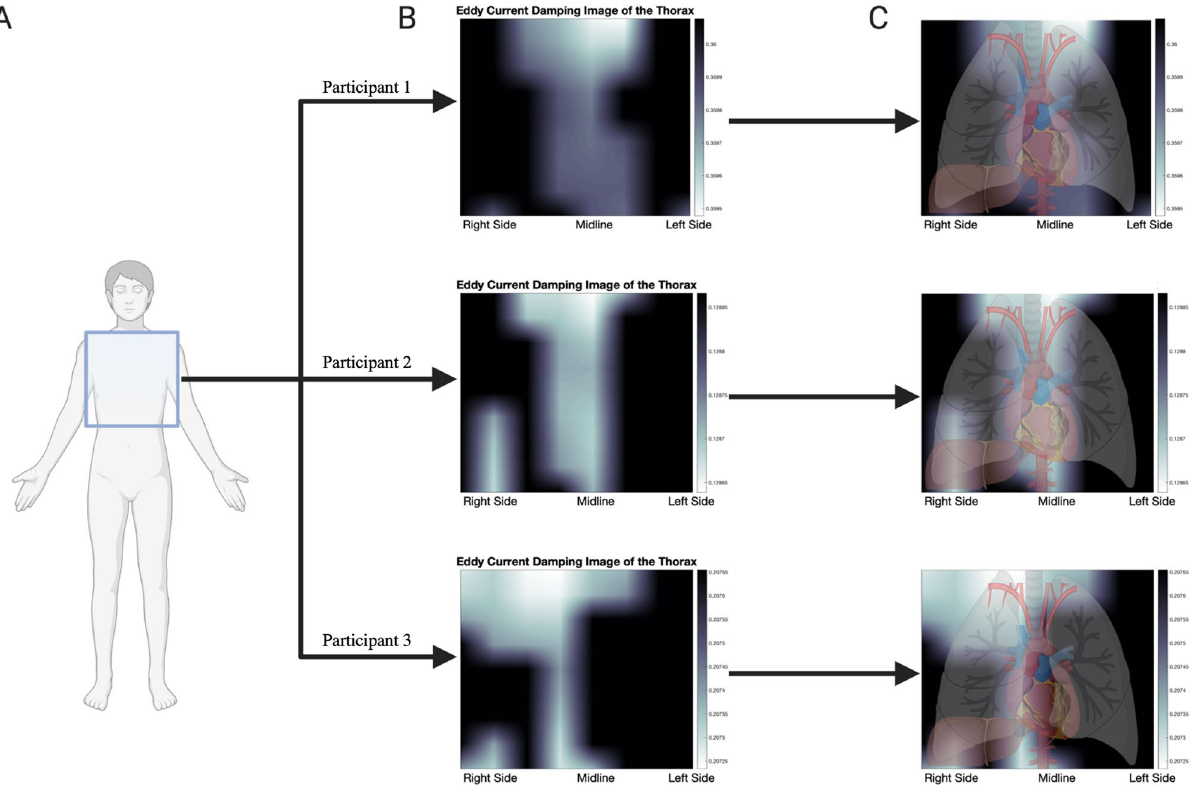
Figure 6. Heatmap images and finite element modeling. ( A ) Eight vertical scanning paths were made around the chest. ( B ) Heatmaps generated using R p values during dynamic scanning of the chest for three different study participants. More conductive regions are shown brighter (higher eddy currents, lower R p ), while less conductive regions are shown darker. ( C ) Heatmaps of the chest with overlaid anatomical landmarks demonstrating high conductivity of vasculature, heart, and liver for three different study